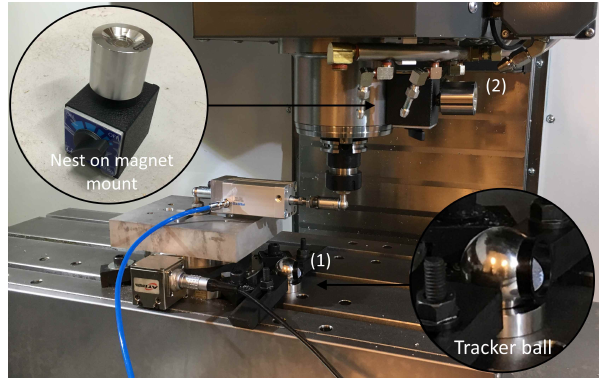
Figure 6: 3-axis CNC, test 1.1: test setup using Faro Xi Laser tracker.